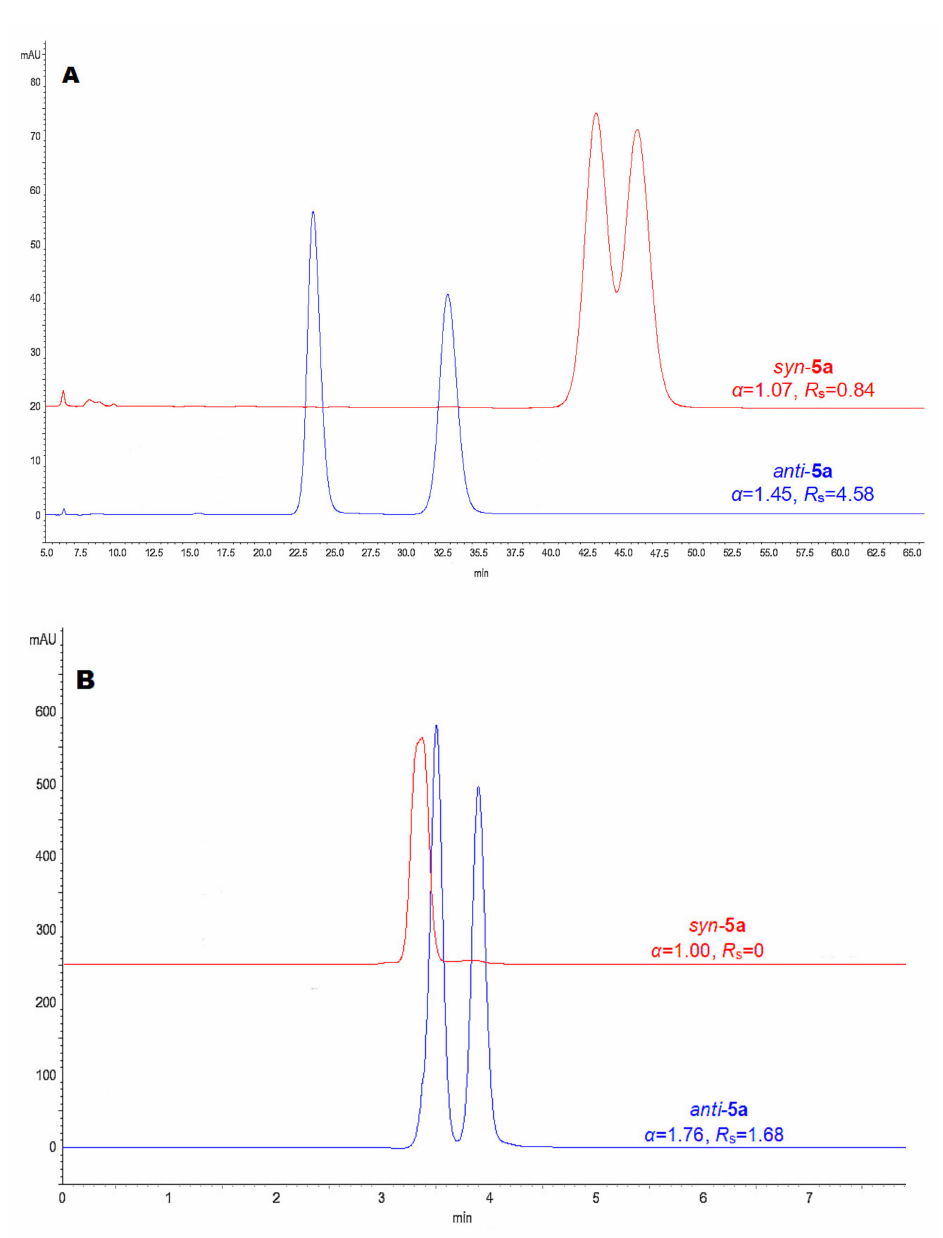
Figure 7. HPLC overlay chromatograms of ( ± )- syn - 5a and ( ± )- anti - 5a on Cellulose-SB column with: ( A ) n -hexane/2-PrOH (90/10, v / v ) and ( B ) 100% DMC as mobile phases. The effects of supercritical carbon dioxide and alcohol modifiers (MeOH, EtOH and 2-PrOH) on the enantioseparation of syn - and anti -hydantoins are listed in Table 2.